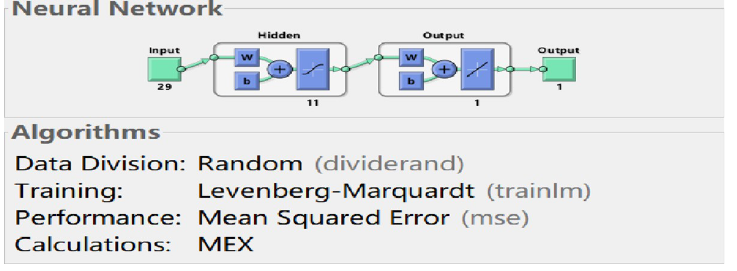
Fig 5. BP neural network structure